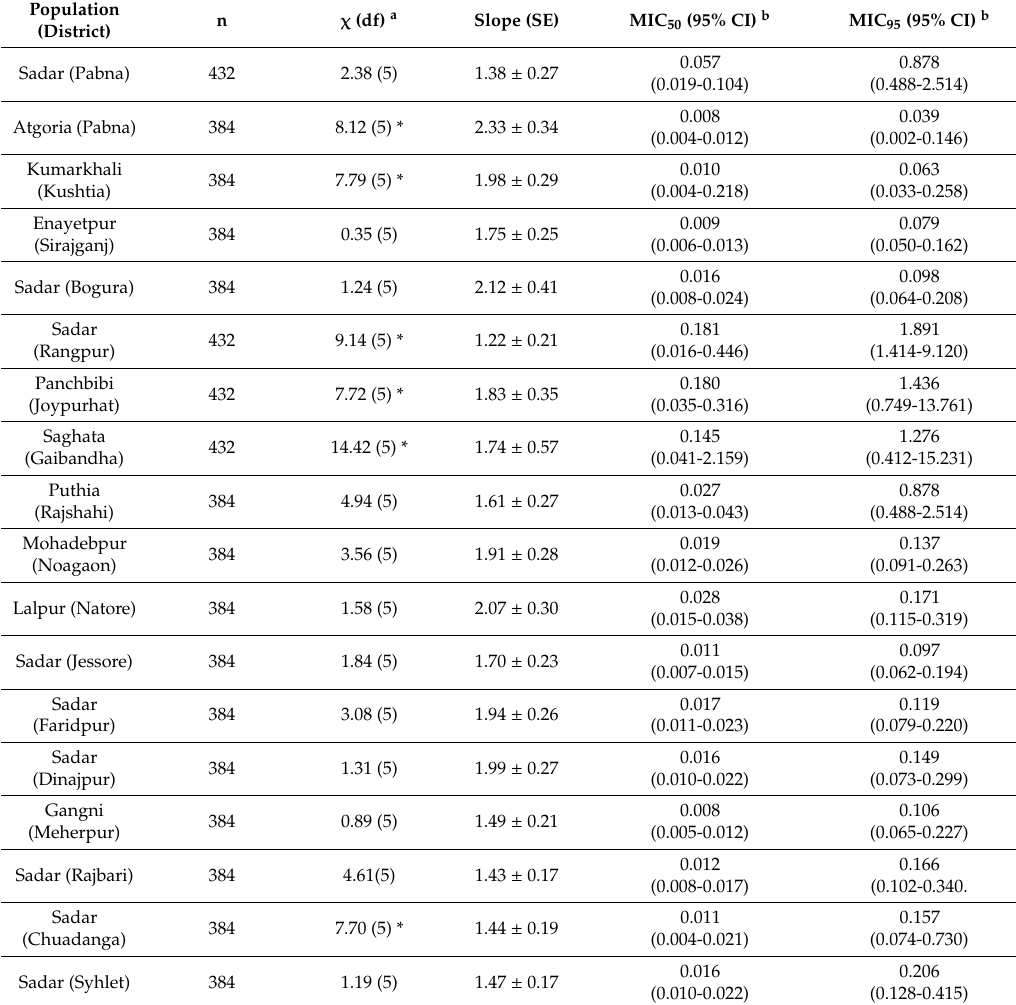
Table 3. Probit analysis of molting inhibitory concentrations (MIC values) of Leucinodes orbonalis neonates to diet-incorporated Cry1Ac protein (ppm). Populations were collected in Bangladesh in